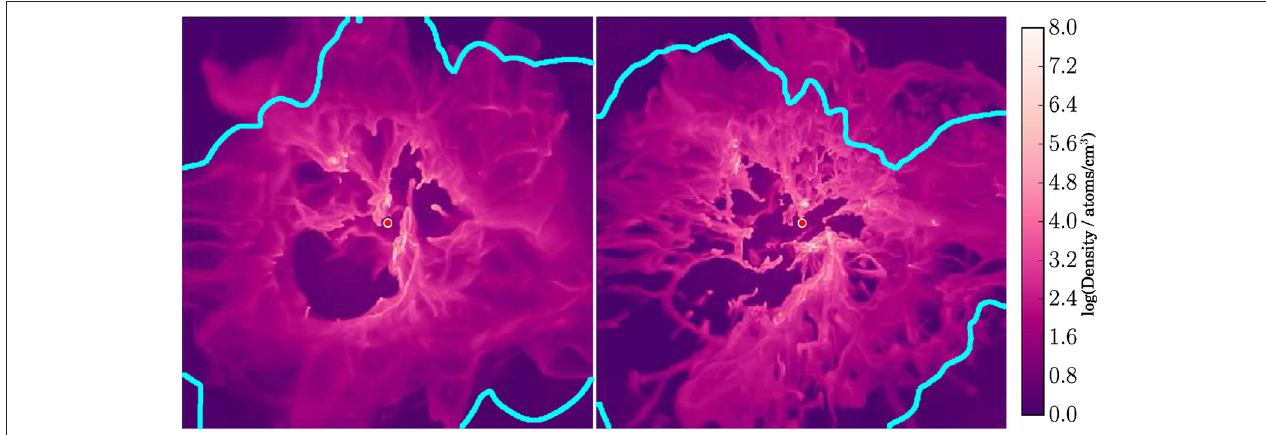
FIGURE 4 | Snapshots of two simulations by Geen et al. (2015), one with a magnetic field (left) and one without (right) . The region shown is a cube 27 pc on a side, with a single ionizing source with a luminosity Q 10 48 ionizing photons s − 1 located at the origin, indicated by the red circle. The slices show the state 2 Myr after the = ionizing source turns on. Color shows the maximum density projected along each line of sight, as indicated by the color bar. The cyan contour marks the region where, somewhere along the line of sight, the ionization fraction exceeds 10%. Notice how the presence of the magnetic field has prevented the H II region from blowing